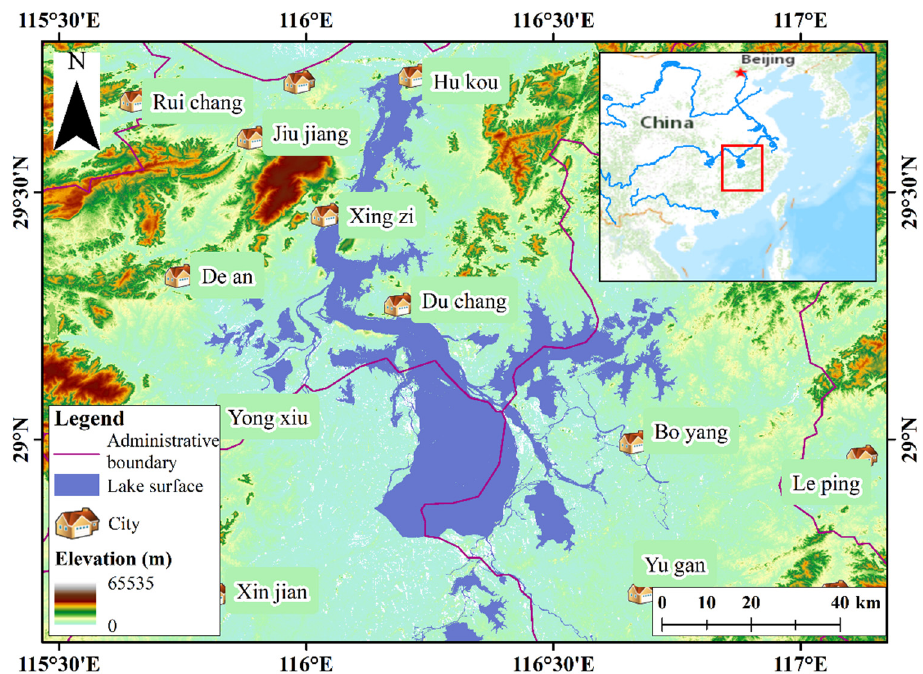
Figure 1. Location of Poyang Lake.